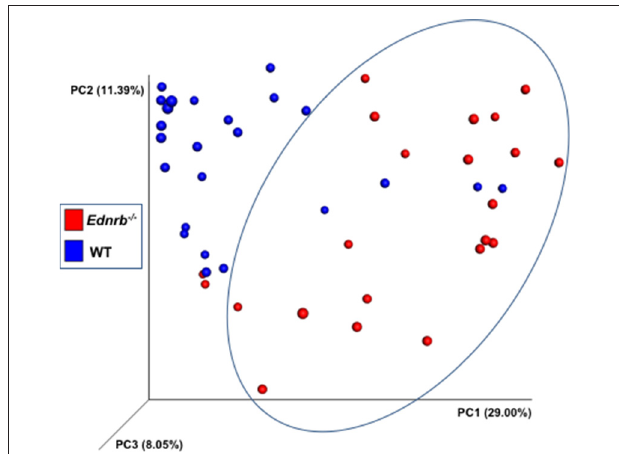
Figure 4 | Bacterial community analyses of fecal bacteria at several times in relation to pull-through surgery from WT and Ednrb −/− mice with and without HAEC. The figure is a principal coordinates analysis (PCoA) of Hellinger beta diversity values generated from 16S rRNA gene sequences ( n = 22 and 24 for Ednrb −/− and WT mice, respectively).